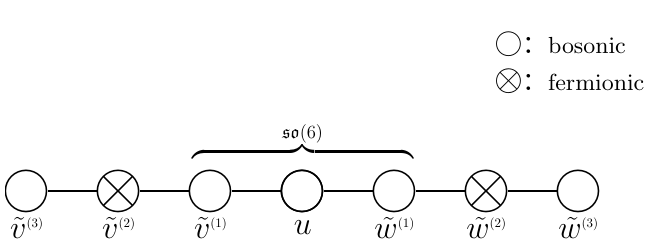
Figure 11 . Beauty grading: the momentum carrying roots u node. These roots determine the anomalous dimension. The auxiliary roots v ( a ) a copy of su (2 2) on each wing and complete the full psu (2 ; 2 j conform a so (6) Dynkin diagram.